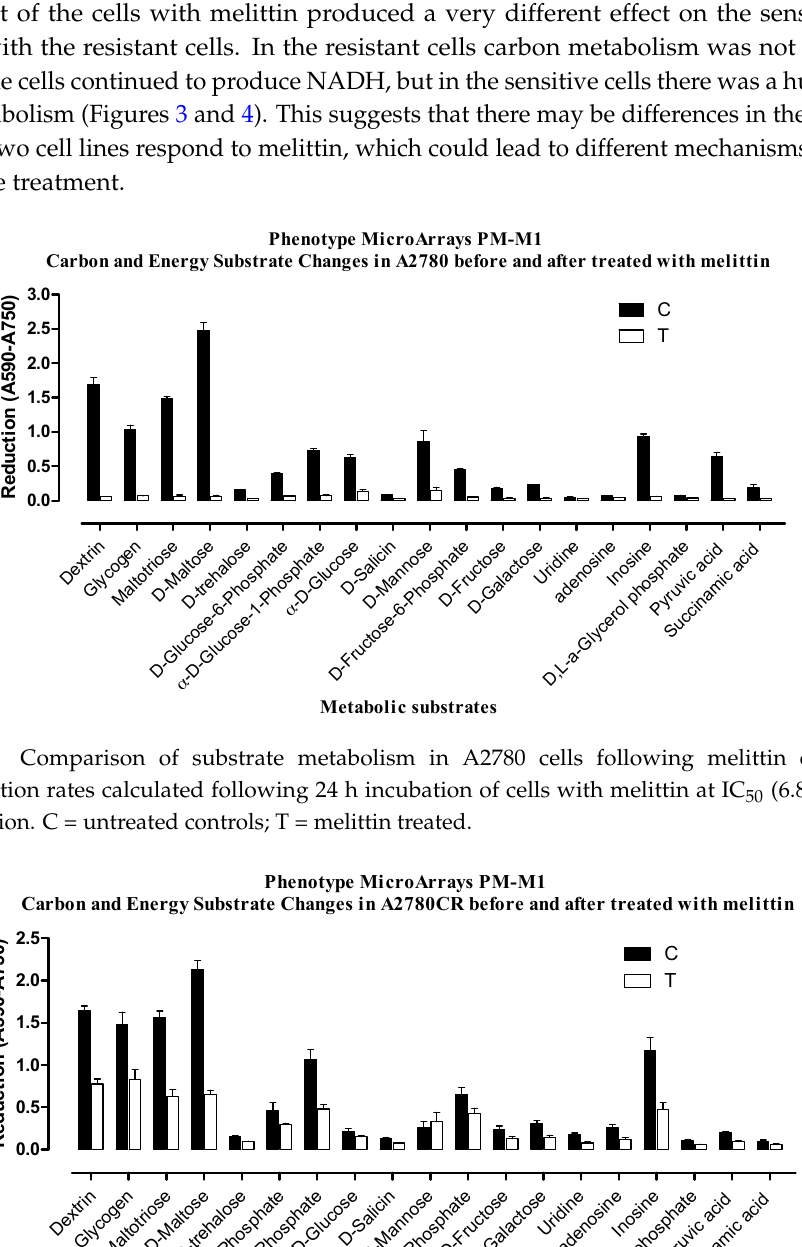
Figure 2. Comparison of substrate metabolism in A2780 and A2780CR. Dye reduction rates calculated following 24 h incubation of cells.